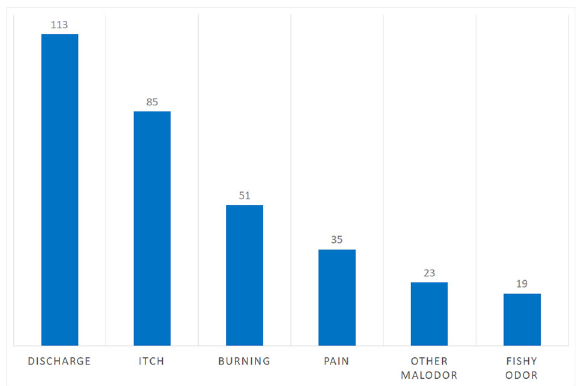
Fig. 3 The distribution of patient-reported vaginal symptoms. The bars depict the number of patients reporting each